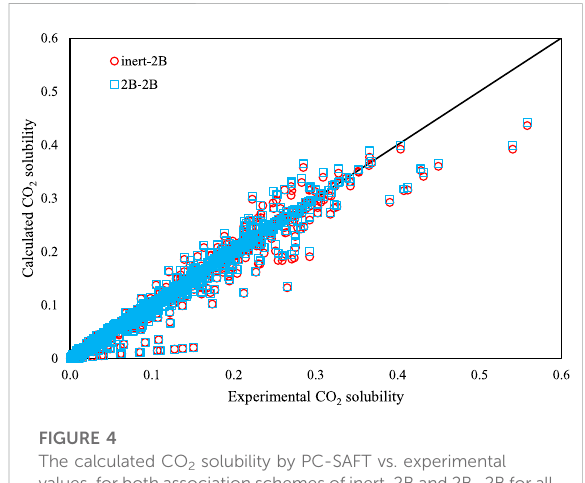
FIGURE 4 The calculated CO 2 solubility by PC-SAFT vs. experimental values, for both association schemes of inert-2B and 2B – 2B for all of the investigated DESs.